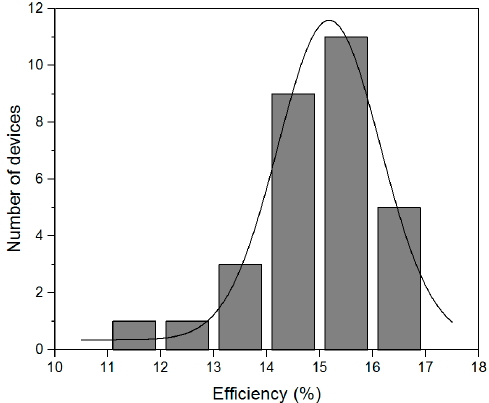
Figure 7. The statistical distribution of 30 solar cell efficiencies fabricated in three successive processes.